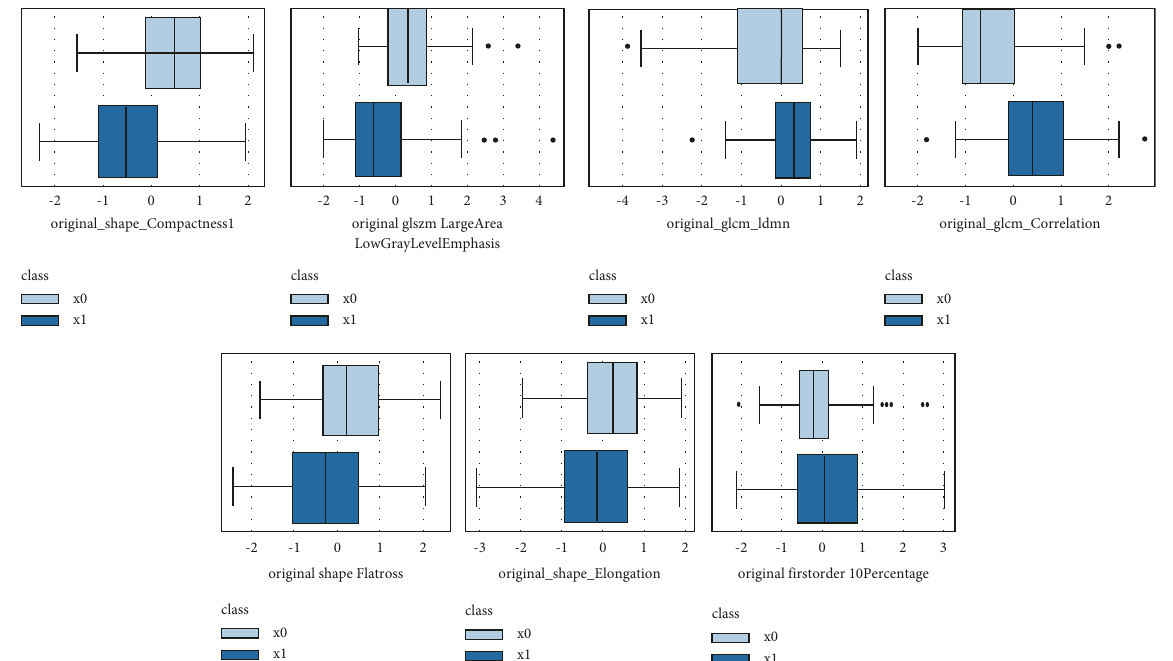
Figure 4: Boxplots of value distribution for five selected quantitative texture features derived from